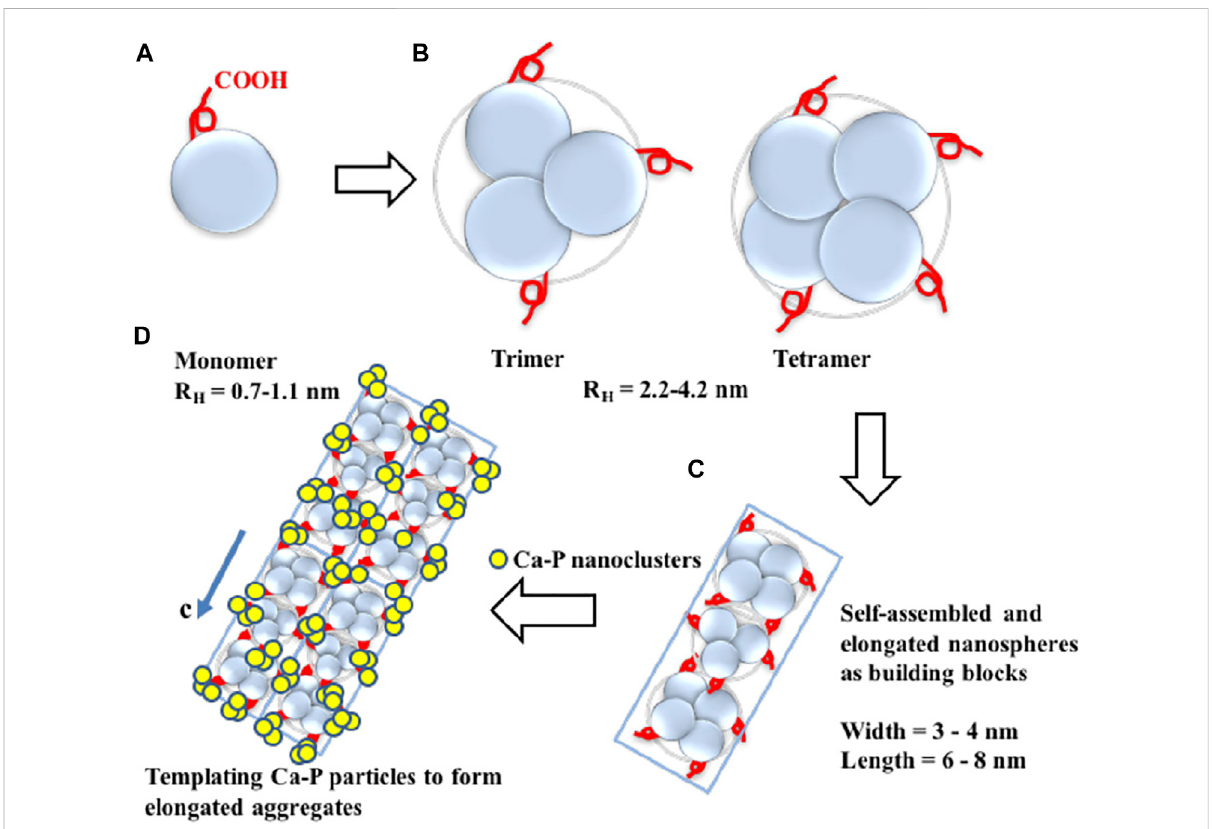
FIGURE 5 Diagram of amelogenin C-terminal peptides self-assembly to guide the extension of OCP crystallization. (A) The monomeric structure of amelogenin ’ s C-terminal peptide. The red curve represents the -COOH terminus. (B) Hydrophobic interactions lead to the formation of oligomeric amelogenin ’ s C-terminal peptides. (C) Nanorod structures as building blocks are formed by the association of oligomers. (D) Elongated organic- inorganiccomplexaggregatesformedbythebuildingblocksnanorodsandCaPnanoclusters.Reprintedwithpermissionfrom[(Wuetal.,2017) ]. Copyright © 2017 American Chemical